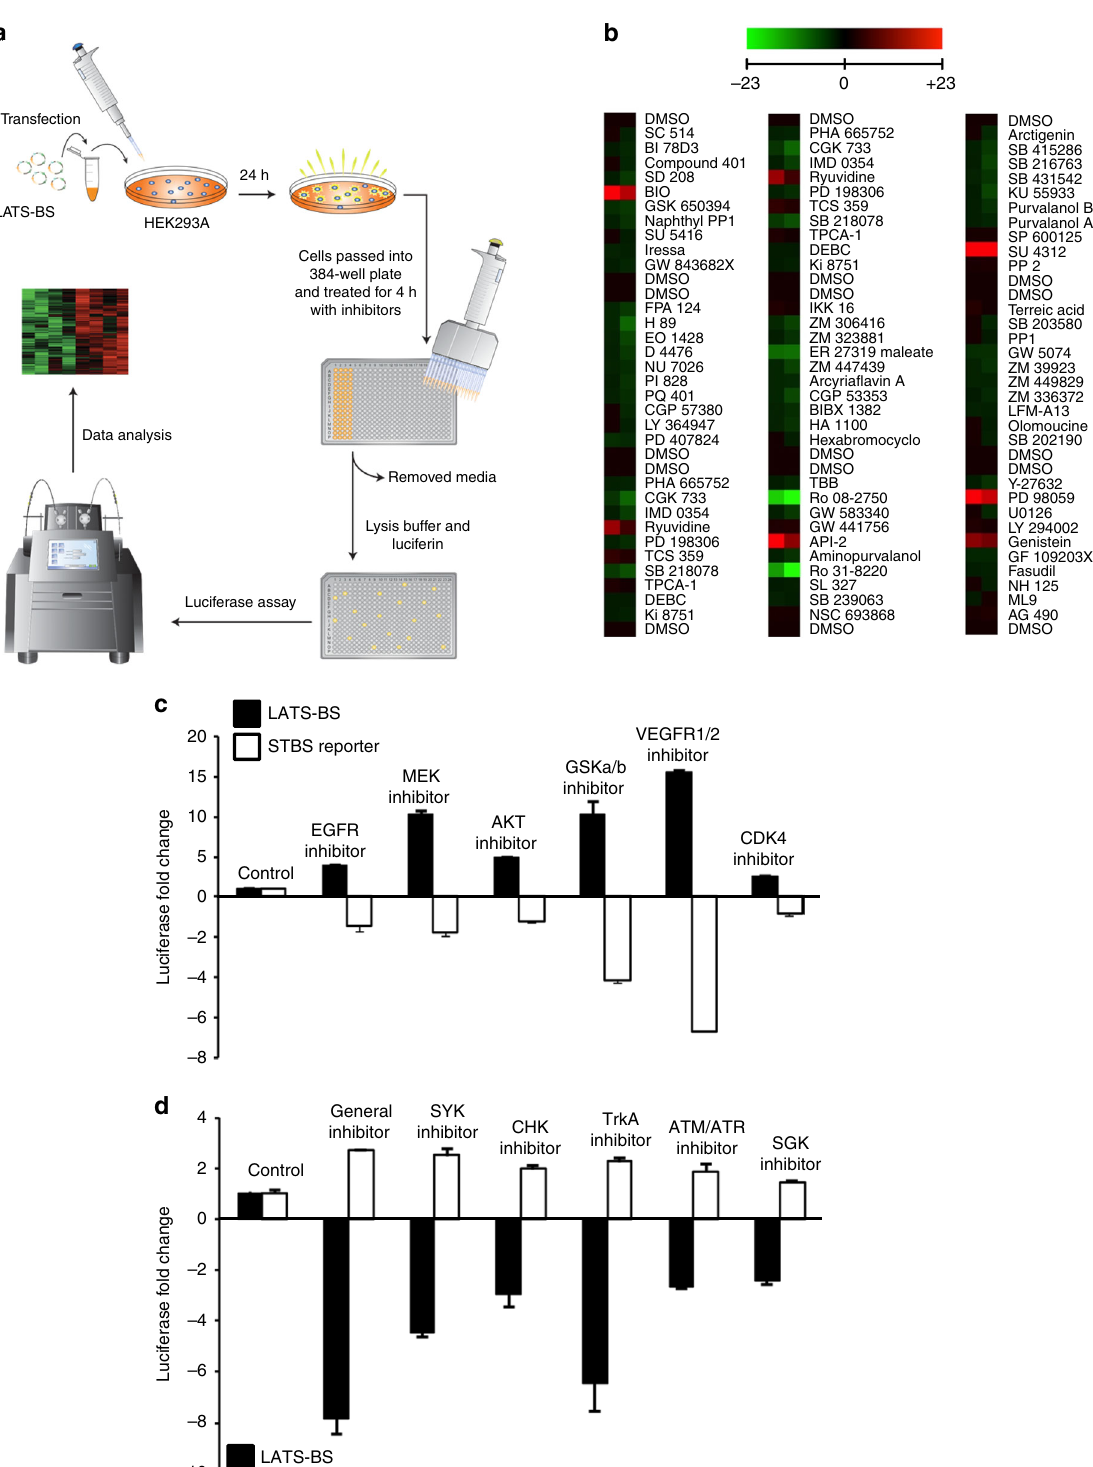
Fig. 3 Kinase inhibitor screen using the LATS-BS. a Experimental design for kinase inhibitor screen. LATS-BS was transfected into HEK293A and cells were passed into a 384-well plate the next day. Forty-eight hours after transfection, cells were treated with a kinase inhibitor library (Tocriscreen Kinase Inhibitor Toolbox) with each drug administered at 10 μ M for 4 h in duplicate. Biosensor activity was measured by luciferase assay. b Heat map summarizing the results of the kinase inhibitor screen. Red color denotes drug treatments that activated the LATS-BS, whereas green color indicates treatments that inhibited the LATS-BS. c , d Validation of the top candidate drugs activating ( c ) or inhibiting ( d ) the LATS-BS from the small-scale kinase inhibitor screen. LATS-BS or STBS-luciferase reporter (YAP/TAZ/TEAD reporter) were transfected into HEK293A. Forty-eight hours after transfection, cells were treated with each inhibitor for 4 h at 10 μ M. Reporter activity was measured by luciferase assay ( n = 3). Data are represented as mean ±